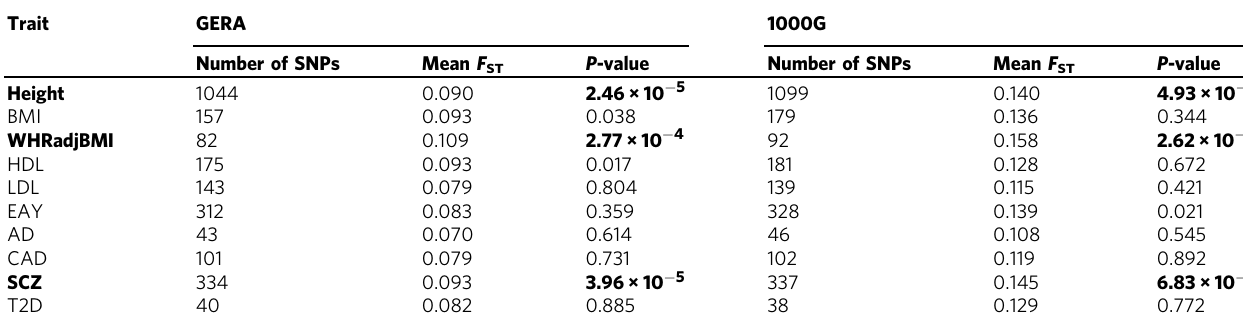
Bold values represent the results that are signi fi cant in GERA and replicated in 1000G, correcting for multiple